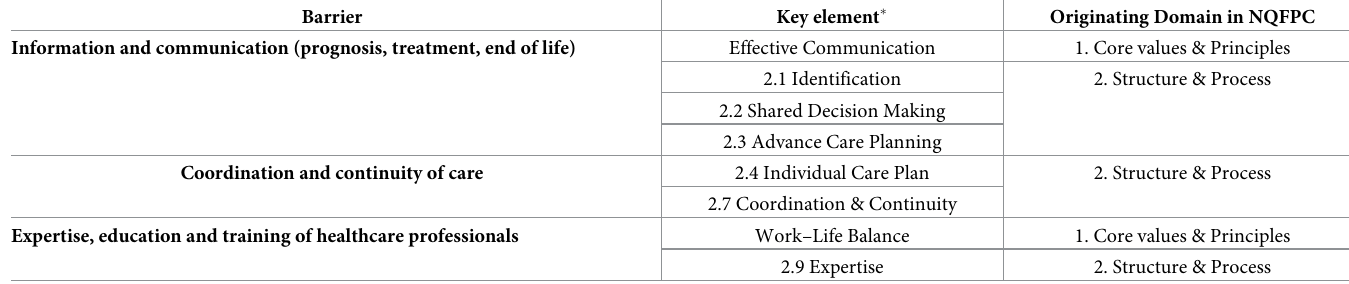
Table 1. Key elements in the quality framework that address barriers from the bottleneck analysis.